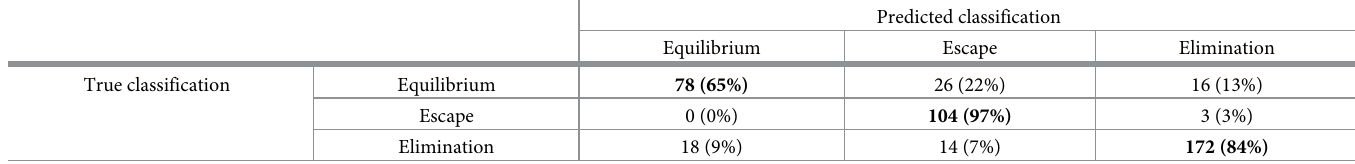
Table 1. Classification performance for 100 principal components. Classifier accuracy (number of classifications and percentage of true classifications assigned to that class) for SVMs trained on the first 100 principal components, based on 431 manually labelled simulations at t = 500 with parameters randomly sampled within a 6-param- eter space. Bold fields show correct